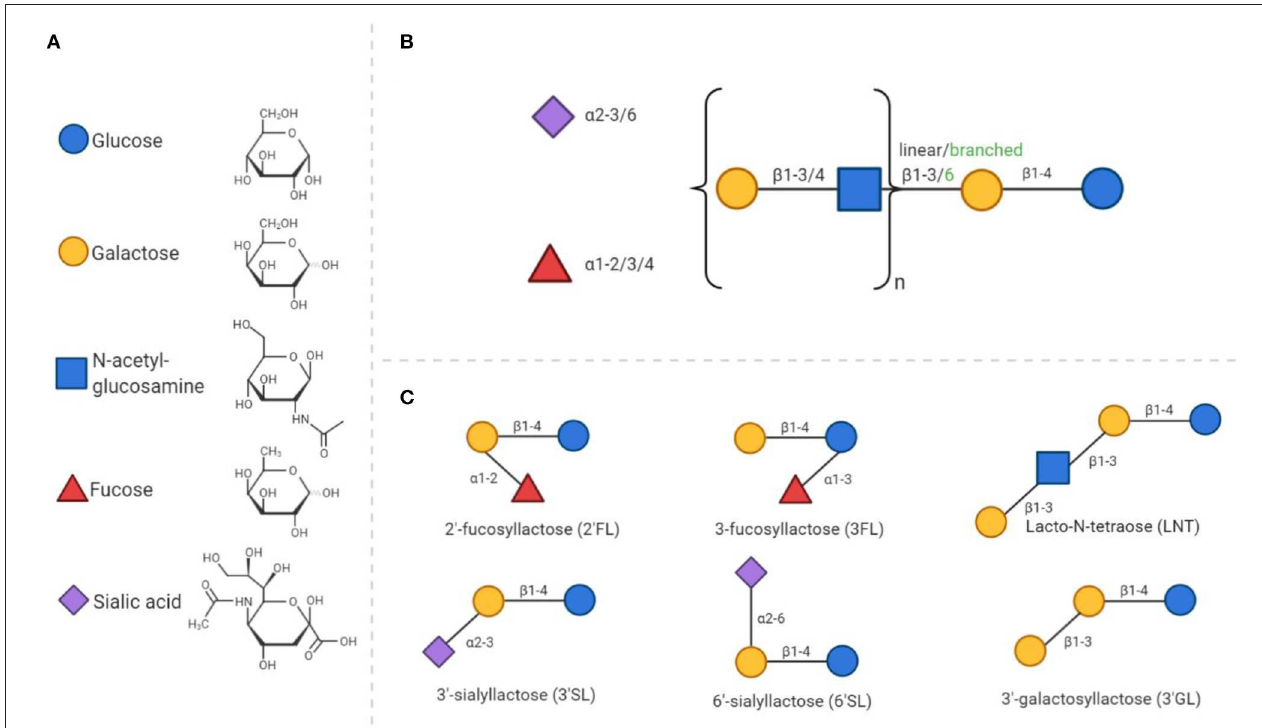
FIGURE 1 | General composition of human milk oligosaccharides and synthetic analogs. (A) All HMOS consist of only 5 different monosaccharides. The chemical structures of these monosaccharides are presented in a D- configuration. (B) The composition of HMOS follows a distinct structure. Elongation of the core structure and decoration with fucose and/or sialic acid residues leads to the large number of different structures discovered to date. (C) As examples, six simple oligosaccharide structures are